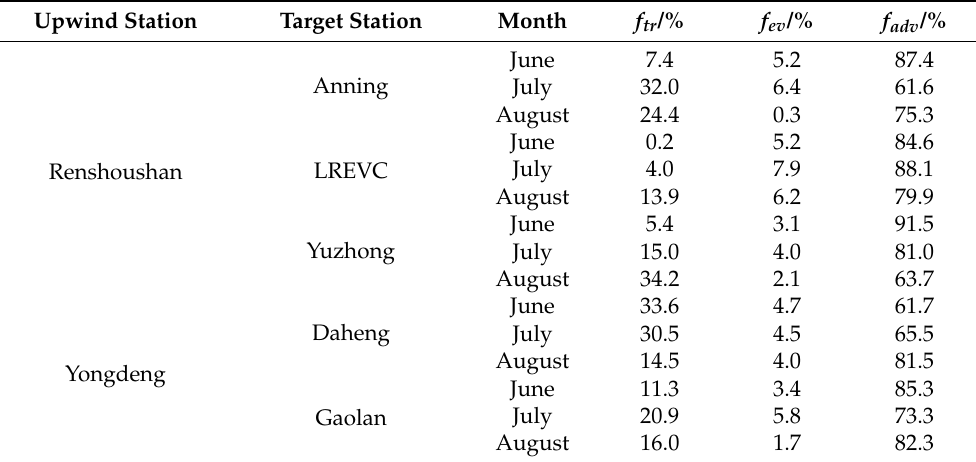
Table 4. Proportion of advected and recycled water vapor during summer months based on three- component mixing